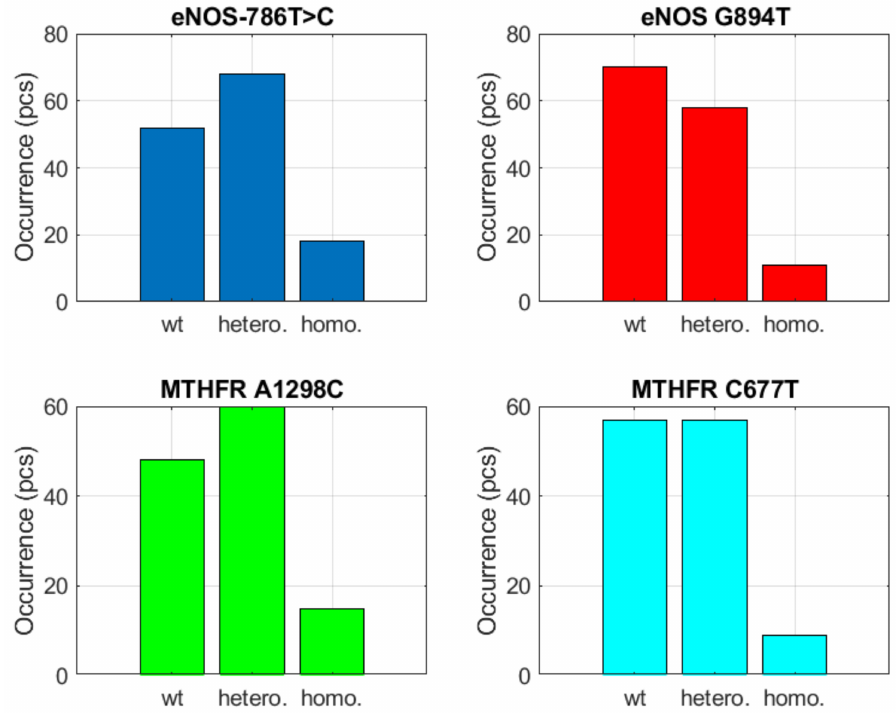
Figure 8. Heterozygous distribution and nonmutant alleles in a 1:1